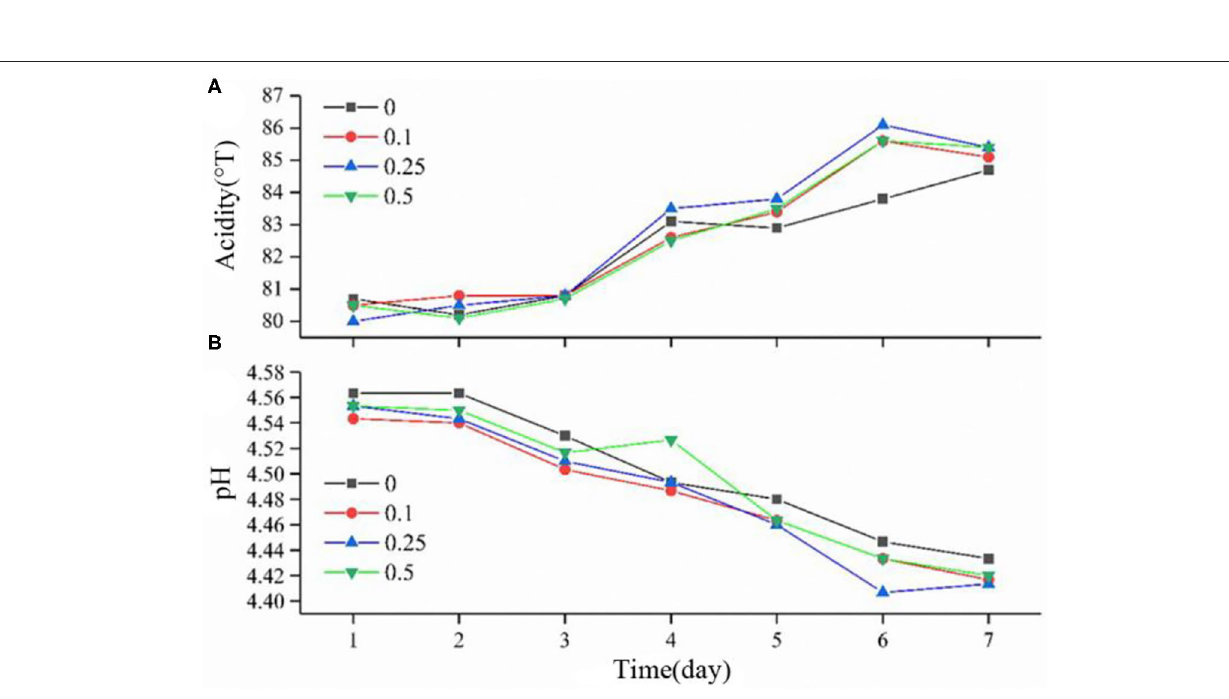
Frontiers in Nutrition |